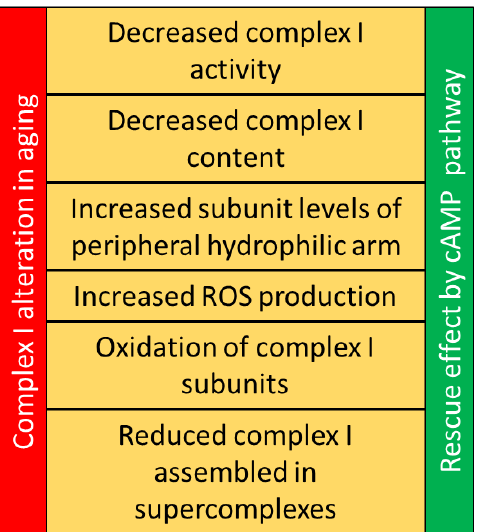
Figure 2. Several alterations have been found to affect complex I during aging process. A functional decline, associated with a decrease of complex I content, has been observed [60,65]. The complex I-dependent ROS production increases with aging in accordance with the increase of oxidation of complex I subunits [2,5,61,62]. Additionally, the superassembly of complex I has been found decreased during aging [93]. Very interesting, a dangerous effect of the subunits belonging to peripheral hydrophilic arm has been observed. In particular, the peripheral subunits hydrophilic arm can form a subcomplex I that oxidize NADH without the proton pumping but producing ROS [71]. cAMP pathway has been found altered during aging process. The cAMP/PKA cascade promotes complex I activity [8,10,55] by increasing the mitochondrial import of the NDUFS4 subunit [98]. Once in mitochondria, the level of the NDUFS4 protein, as well as, the other peripheral subunits, is sustained by mitochondrial cAMP pool [31]. This can allow a dynamic exchange between the new imported subunits and the already assembled probably oxidized ones, as found for NDUFV2 and NDUFS4 [31,37,55]. The PKA-dependent phosphorylation of the NDUFS4 subunit is found associated with the cAMP-dependent increase of complex I assembly in supercomplex [58].